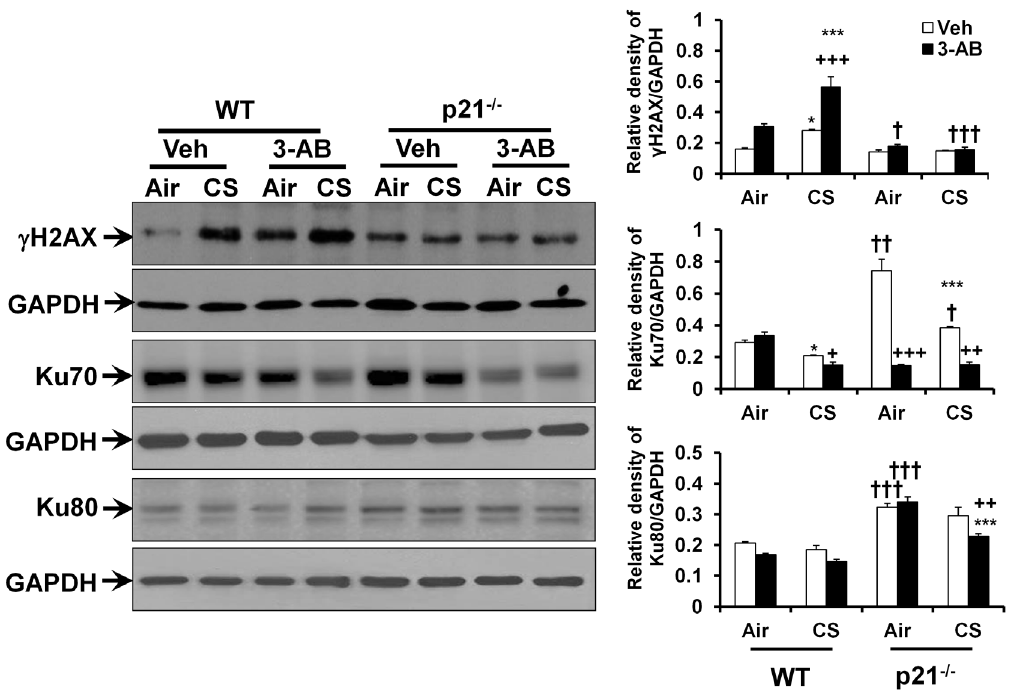
Figure 2. p21 deletion decreases the level of c H2AX but augments the levels of Ku70 and Ku80 in mouse lung, which was affected by PARP-1 inhibitor. c H2AX level was decreased, whereas the levels of Ku70 and Ku80 were augmented in lungs of p21 -/- mice compared to WT mice exposed to CS. 3-AB treatment further increased c H2AX level, but reduced the levels of Ku70 in WT mice. Gel pictures shown are representative of at least 3 separate mice. Relative density ratio is indicative of results after normalizing to corresponding GAPDH. Data are shown as mean 6 SEM (n=3per group). * P , 0.05, *** P , 0.001 vs air group; ++ P , 0.01, +++ P , 0.001, vs Veh group; { P , 0.05, {{ P , 0.01, {{{ P , 0.001 vs WT mice.